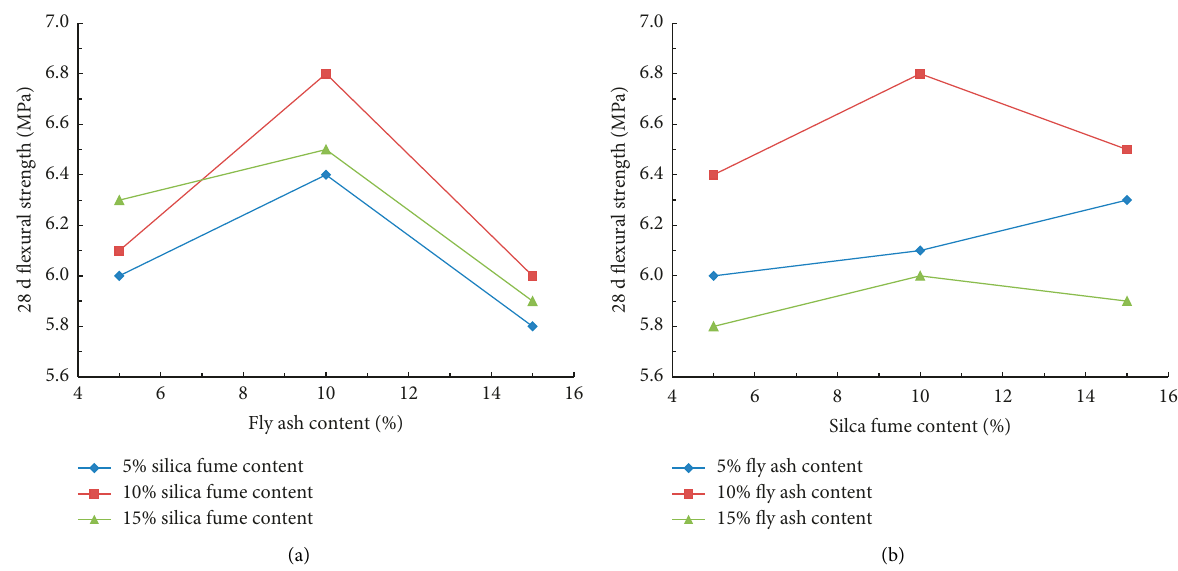
Figure 12: Influence of fly ash and silica fume on the flexural strength of MPPF coral concrete. (a) The influence of fly ash content on the flexural strength of concrete. (b) The influence of silica fume content on the flexural strength of